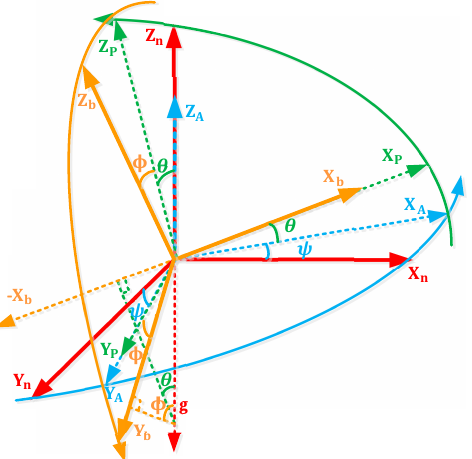
Figure 10. Geometrical and rotational relationships between the body frame and the geographic frame for gyro-compassing alignment.